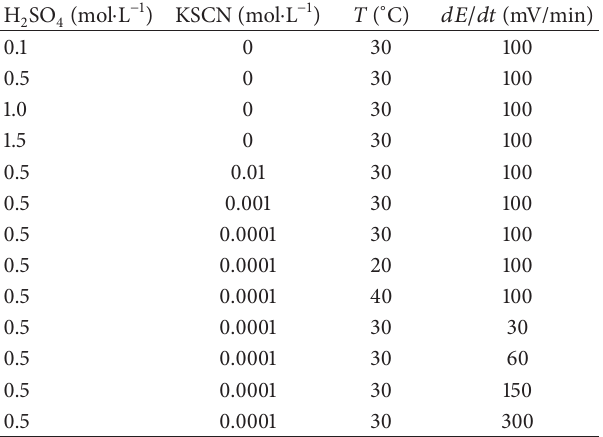
Table 2: Design of experiments for the optimization of DL-EPR test